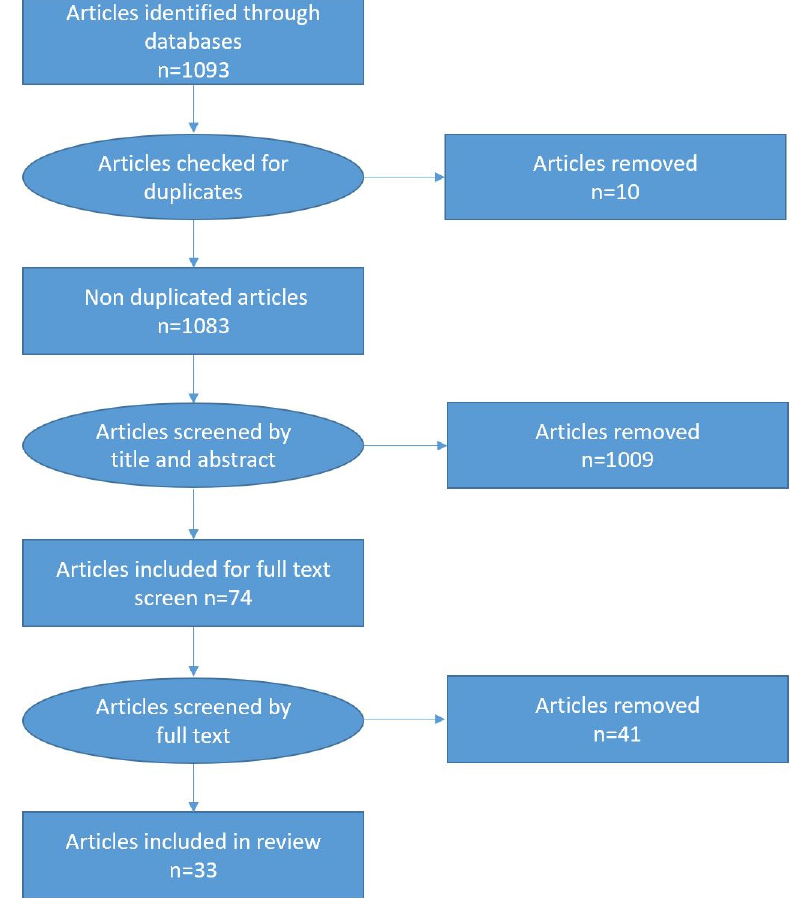
Figure 1. Search process of identified articles.